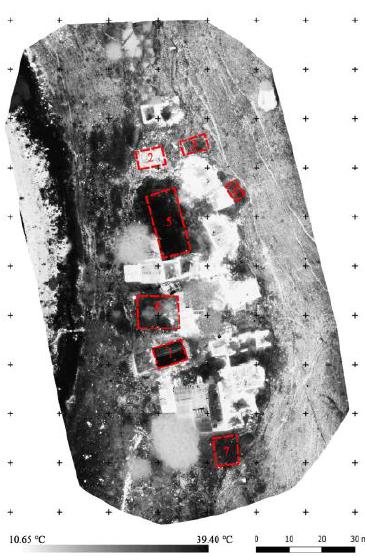
Figure 14. Seven areas (red dashed polygons) were deemed worthy of more detailed investigations according to their thermal discontinuity as well as in relation to their shape and orientation, fitting an anthropized pattern.